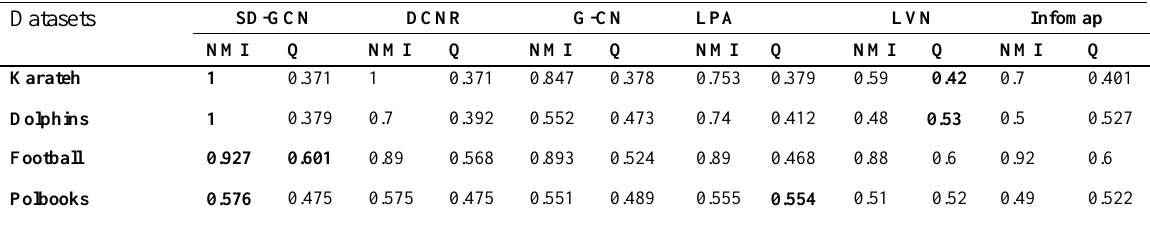
Table 4. Experiment results on small real-world networks with ground-truth communities.